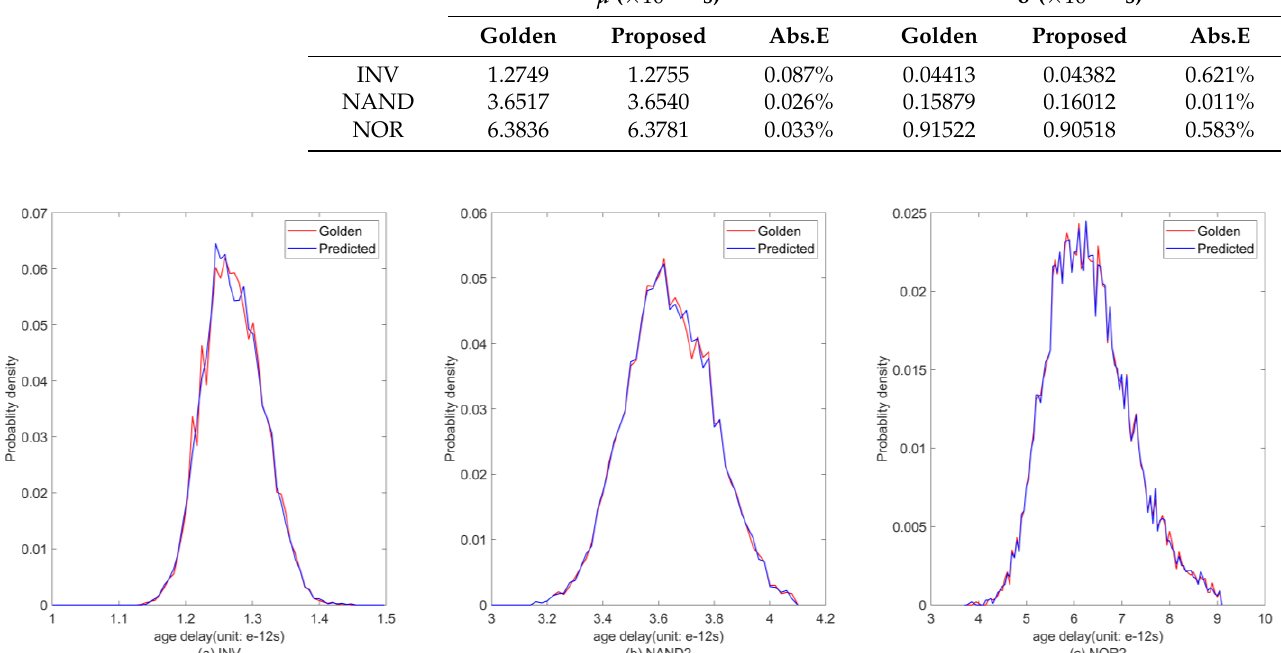
Figure 6. The probability density of the golden and predicted test data: ( a ) INV gate; ( b ) NAND2 gate; ( c ) NOR2 gate.